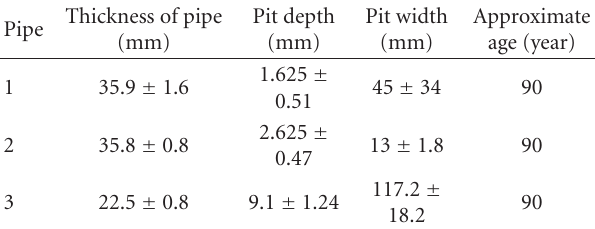
Table 1: Information on pipes and